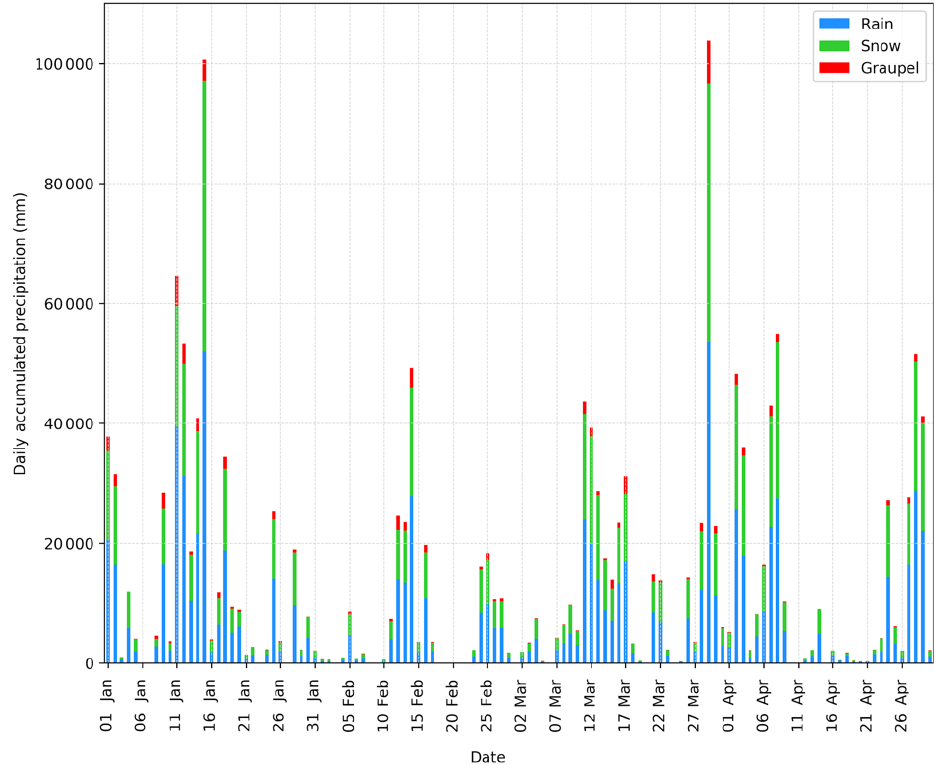
Figure 6. Daily accumulated precipitation (mm) within transition regions under PGW over the January–April 2010 period, organized by rain (blue), snow (green) and graupel (red). Freezing rain occurrence was minimal and was not shown.